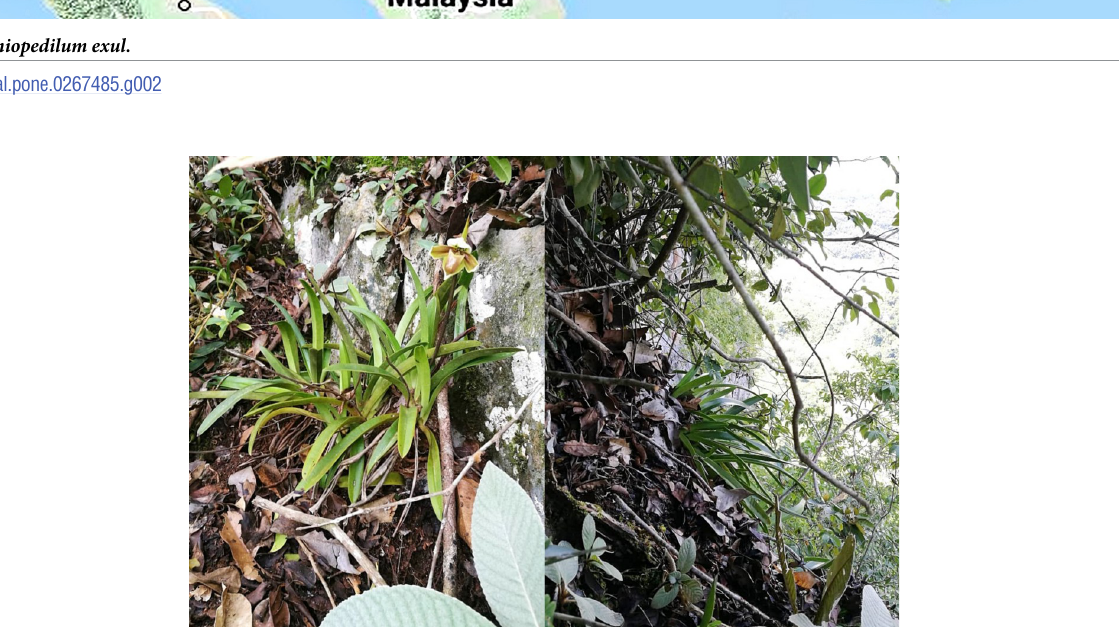
PLOS ONE | https://doi.org/10.1371/journal.pone.0267485 April 26,